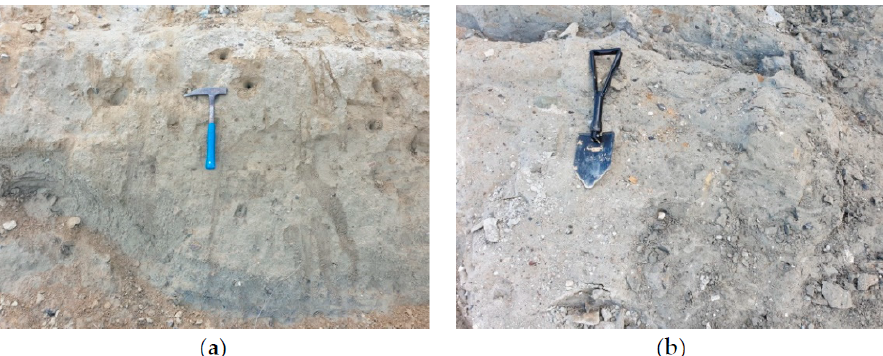
Figure 1. Sampling locations of the till soils in Heiligenhafen area, northern Germany: ( a ) “oberer Geschiebemergel, weichselzeitlich (Weichselian)” (oM) glacial till deposit, location 54 ◦ 22 (cid:48) 55.0 (cid:48)(cid:48) N 10 ◦ 56 (cid:48) 12.9 (cid:48)(cid:48) E (54.381951, 10.936909); ( b ) “mittlerer Geschiebemergel, saalezeitlich (Saalian)” (mM) glacial till deposit, location 54 ◦ 22 (cid:48) 54.6 (cid:48)(cid:48) N 10 ◦ 56 (cid:48) 06.4 (cid:48)(cid:48) E (54.381833, 10.935111).